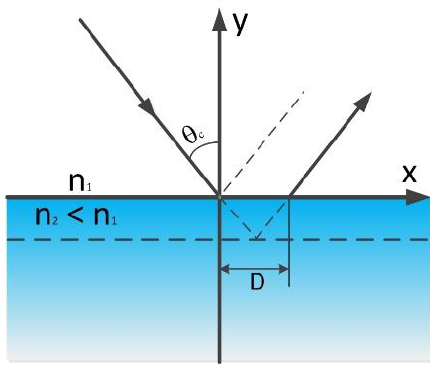
Figure 1. Schematic diagram of the Goos – Hänchen (GH) shift.